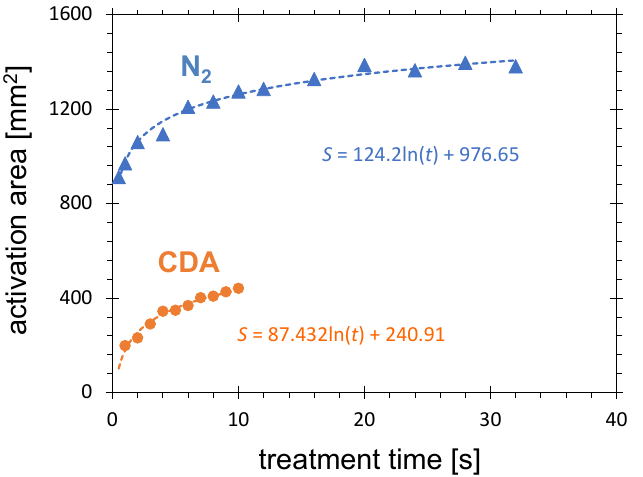
Figure 7. Influence of treatment time on the activation area and for CDA and N 2 flow of 8.0 SLM, distance between the PCPG tip and the HDPE substrate of 5.5 mm, and the PCPG input power of 8.0